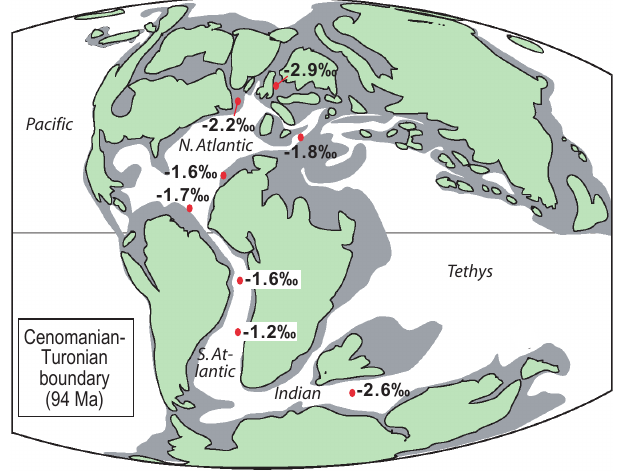
Fig. 6. Average δ 15 N sed for Cenomanian–Turonian boundary units. Note the limited range of δ 15 N sed values ( − 2.9‰ to − 1.2‰) for sites ranging from high northern to high southern paleolatitudes, implyinga relatively uniform contemporaneous seawater δ 15 N composition. Data sources in Table